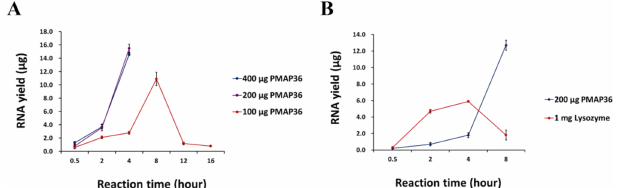
Figure 1. Effects of peptide concentration and reaction time on RNA yields using porcine myeloid antimicrobial peptide 36 (PMAP-36) and lysozyme from S. aureus and S. typhimurium . ( A ) 1 × 10 9 cells were added to 150 µ L reaction mixture. 100, 200, and 400 µ g of PMAP-36 incubated with S. aureus for varying reaction times. ( B ) Results from the use of 200 µ g PMAP-36 and 1 mg lysozyme for varying reaction times against S. typhimurium. S. aureus , Staphylococcus aureus ; S. typhimurium , Salmonella typhimurium .